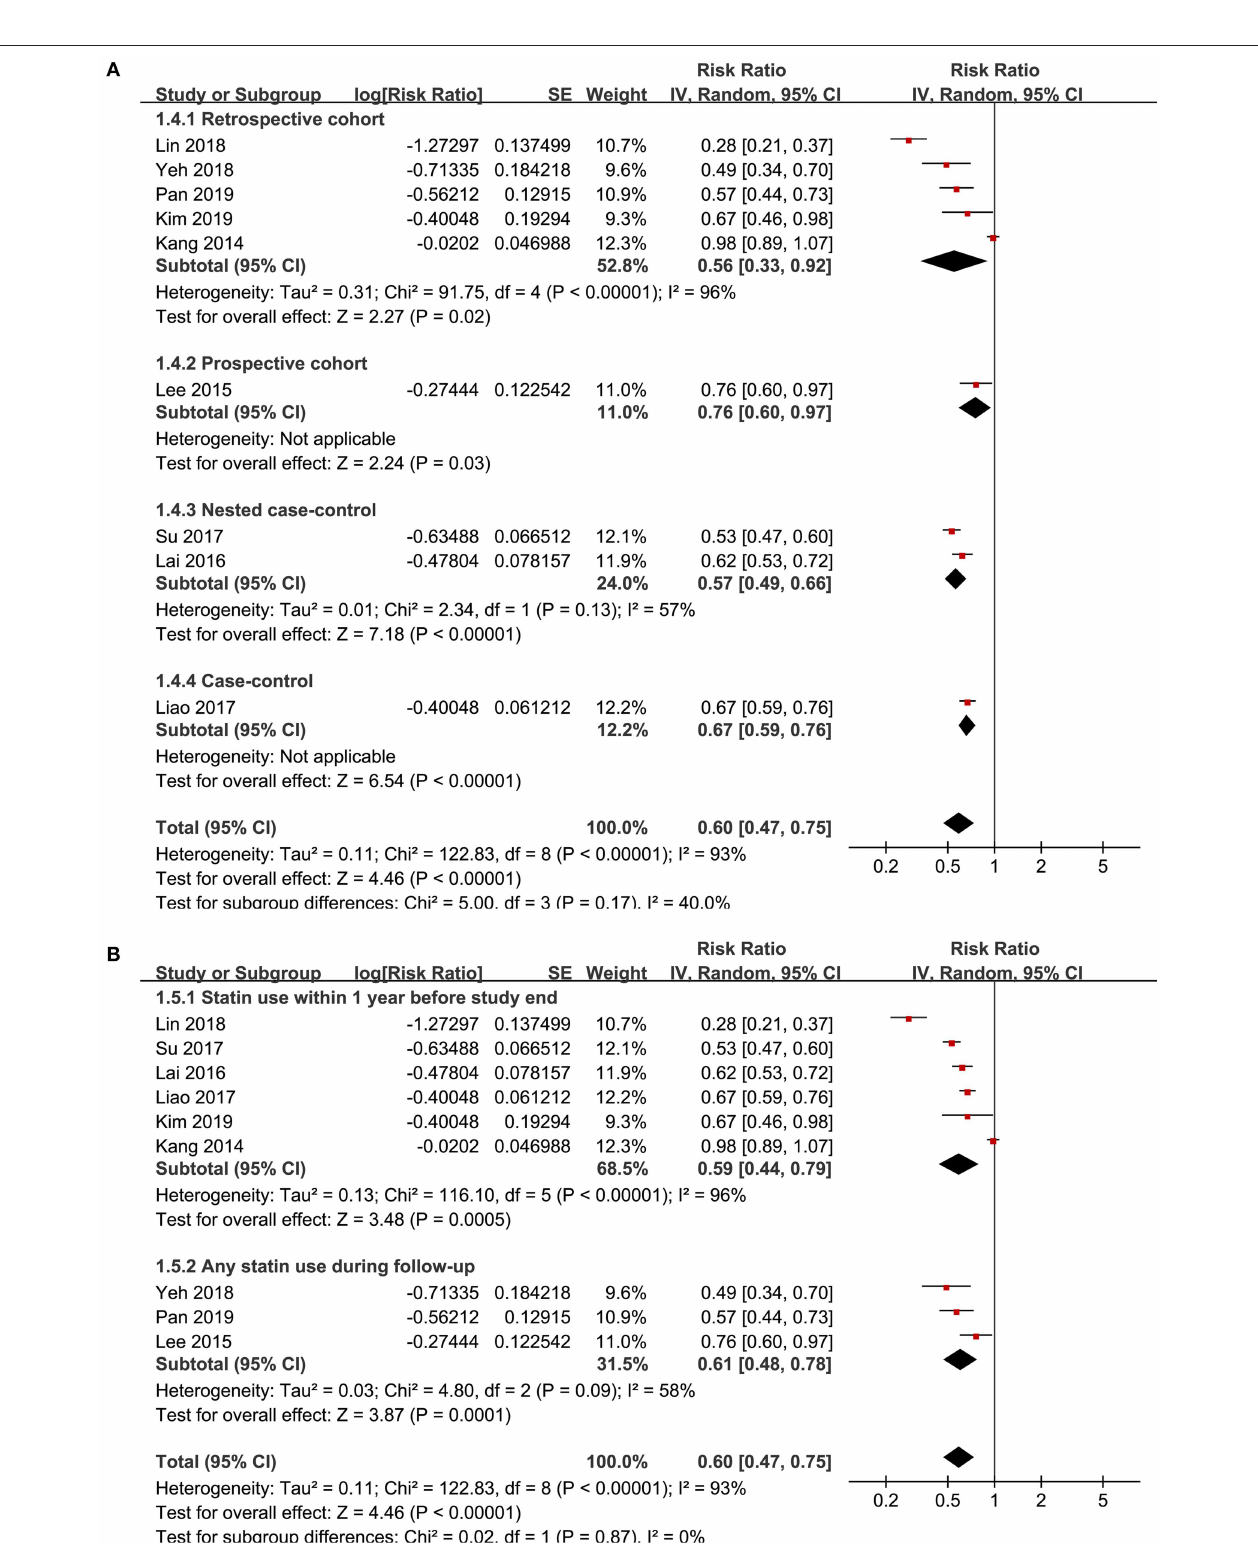
FIGURE 4 | Subgroup analyses for the association between statin use and active tuberculosis infection. (A) Subgroup analyses according to the study design characteristics and (B) subgroup analyses according to the definition of statin use.